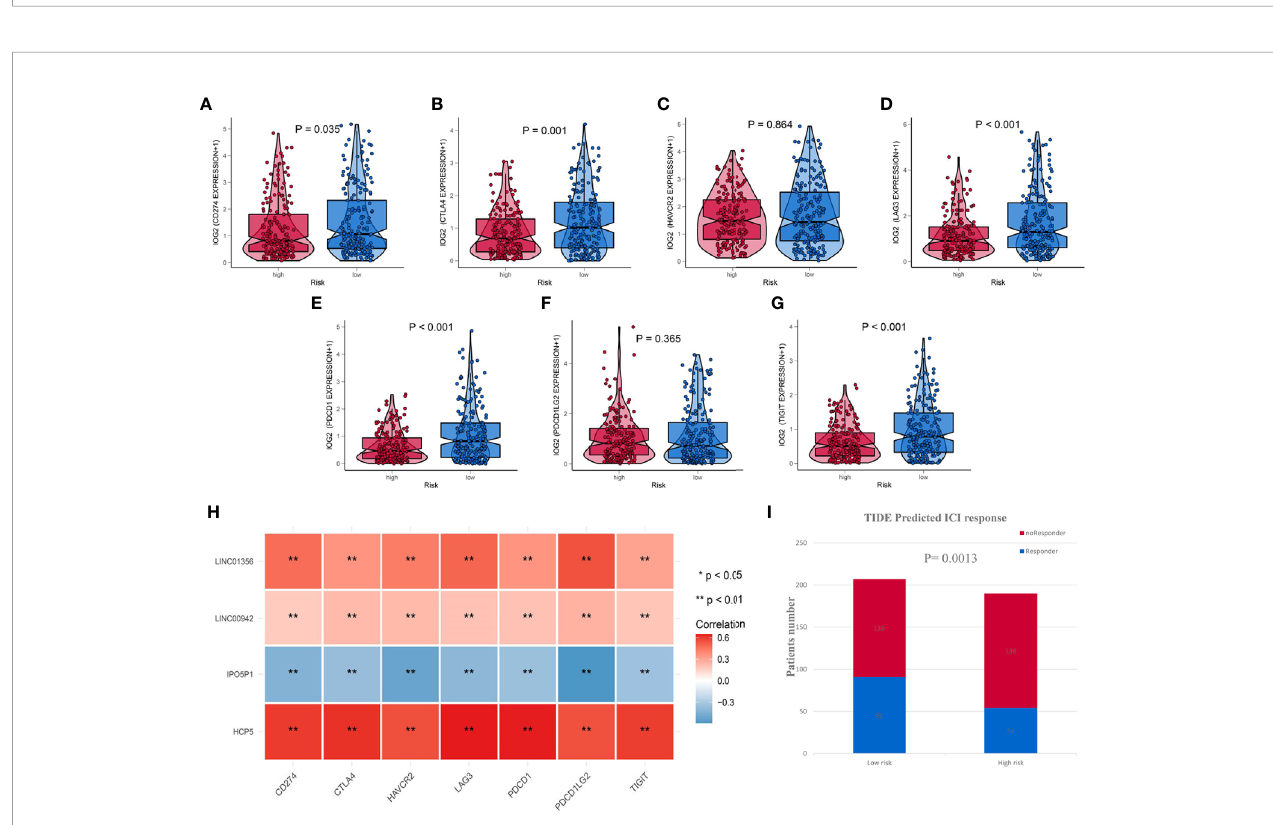
FIGURE 8 | IRL-signature was ef fi cient in prediction the immunotherapeutic bene fi t in BLCA (A – G) Box-Violin plots visualized the correlation between Risk score and immune-checkpoint-relevant genes, CD274 (A) CTLA-4 (B) , HAVCR2 (C) , LAG3 (D) , PDCD1 (E) , PDCD11LG2 (F) , and TIGIT (G) . (H) Correlation heatmap of four immune-related lncRNAs and seven immune-checkpoint-relevant genes. (I) The distribution of immunotherapeutic response in indicated groups strati fi ed by IRL-signature in TCGA-BLCA cohort based on the TIDE algorithm. **P < 0.01.